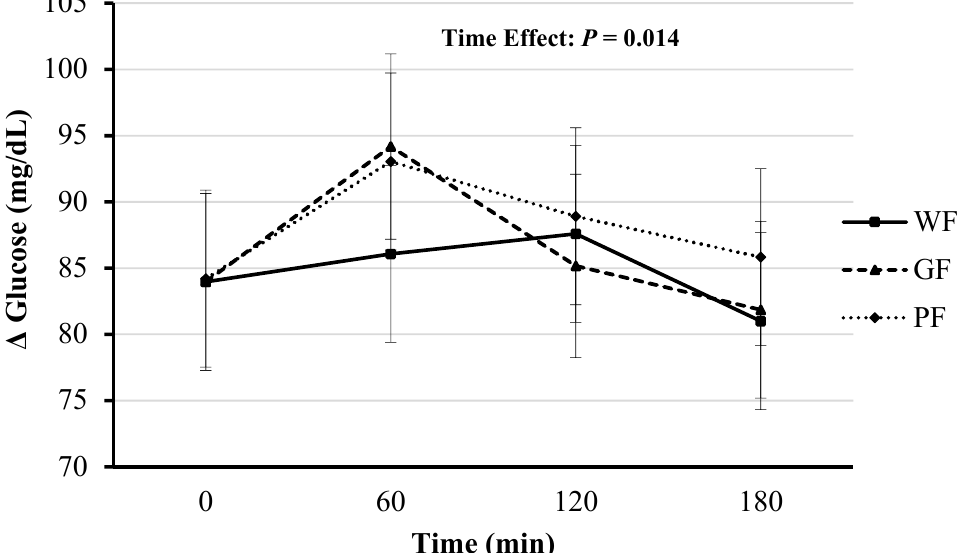
Figure 5. Comparison of blood glucose responses after the consumption of whole foods (WF), gluten-free (GF) and processed (PF) meals. Significant time effect for all three conditions ( p < 0.05). Values displayed as means ±95% confidence intervals.